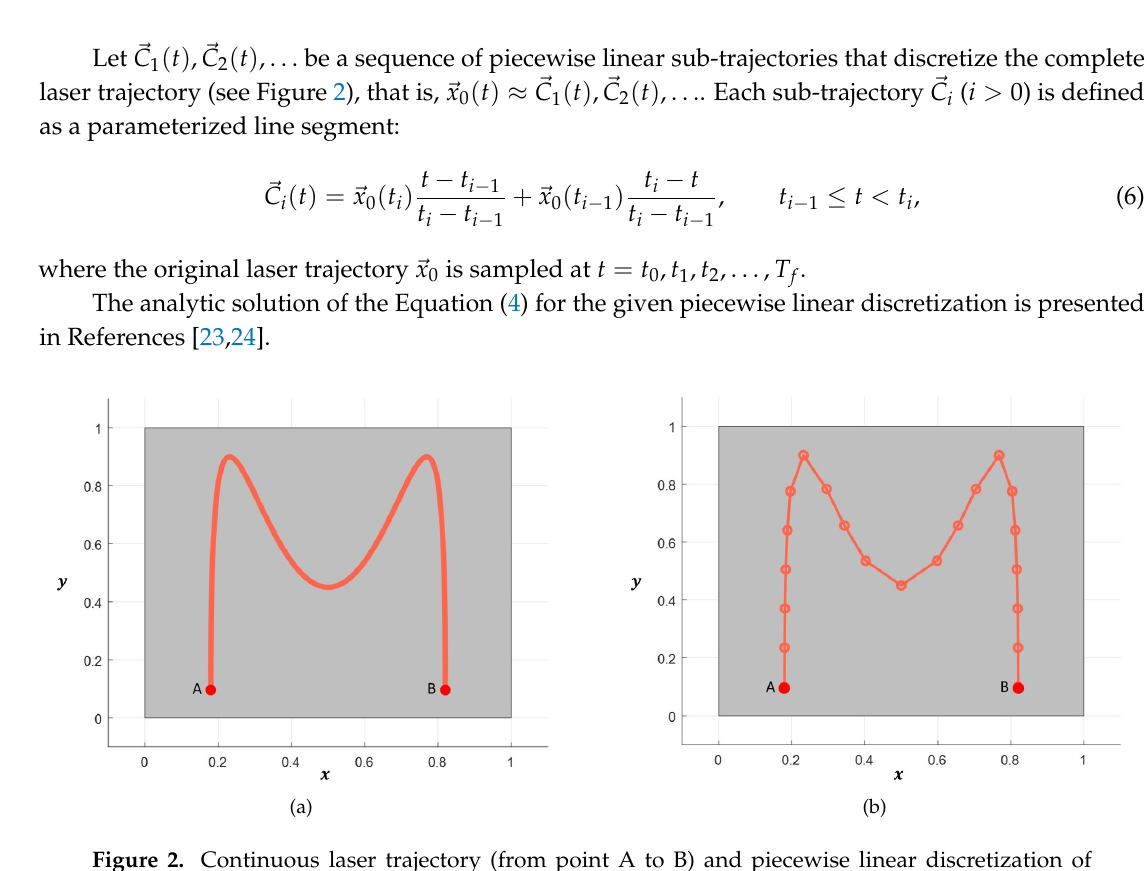
Figure 2. Continuous laser trajectory (from point A to B) and piecewise linear discretization of the trajectory on a rectangular plate. ( a ) Continuous laser trajectory; ( b ) (Coarse) Piecewise linear discretization of the